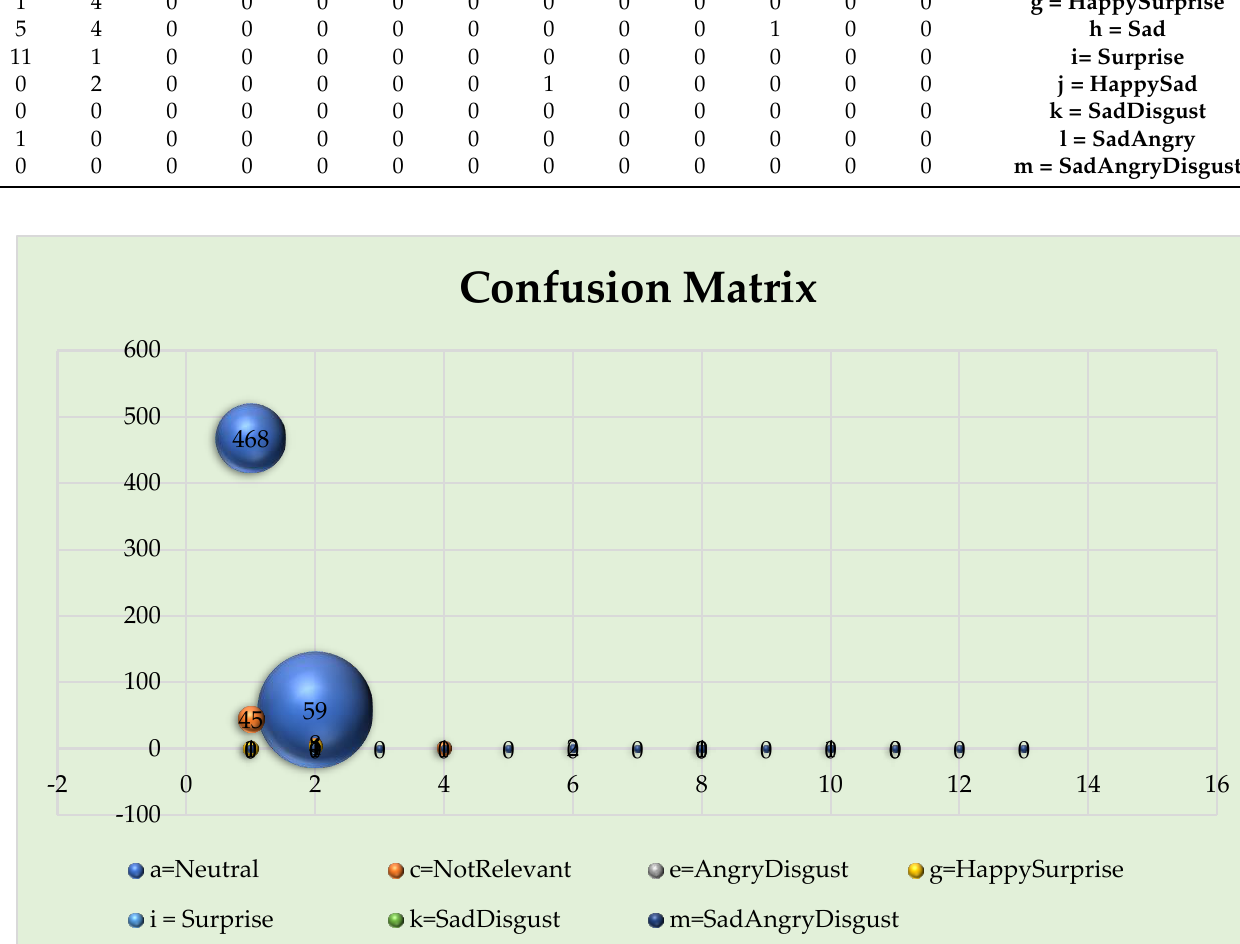
Table 6. Run information (tetrad feature selection techniques).